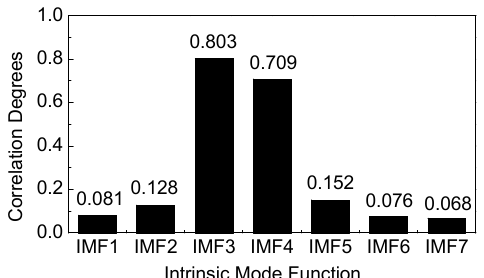
Figure 13. Correlation values of respective IMF components from the noisy observation sequence.